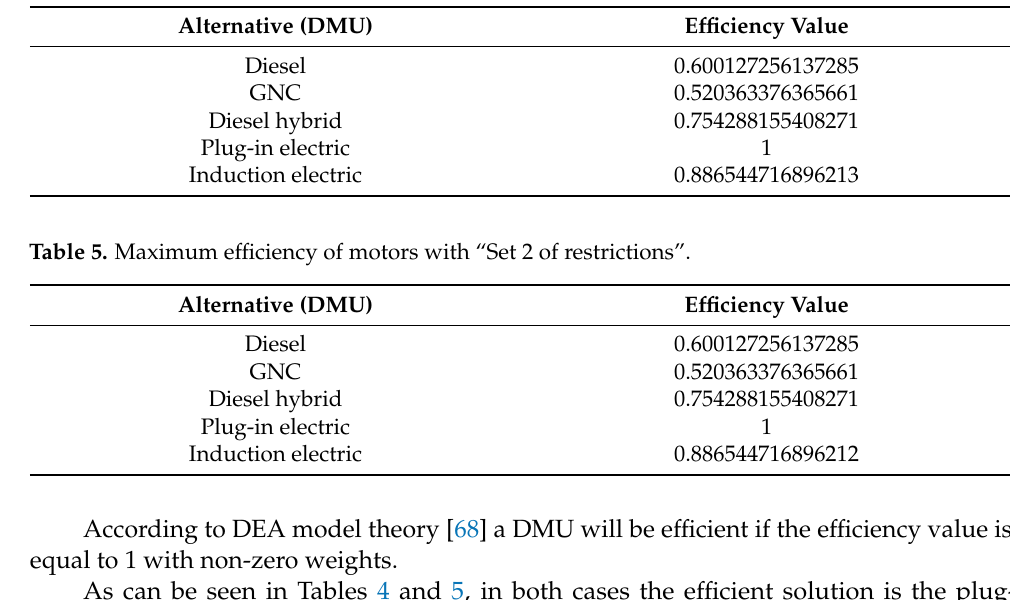
Table 4. Maximum efficiency of motors with “Set 1 of restrictions”.